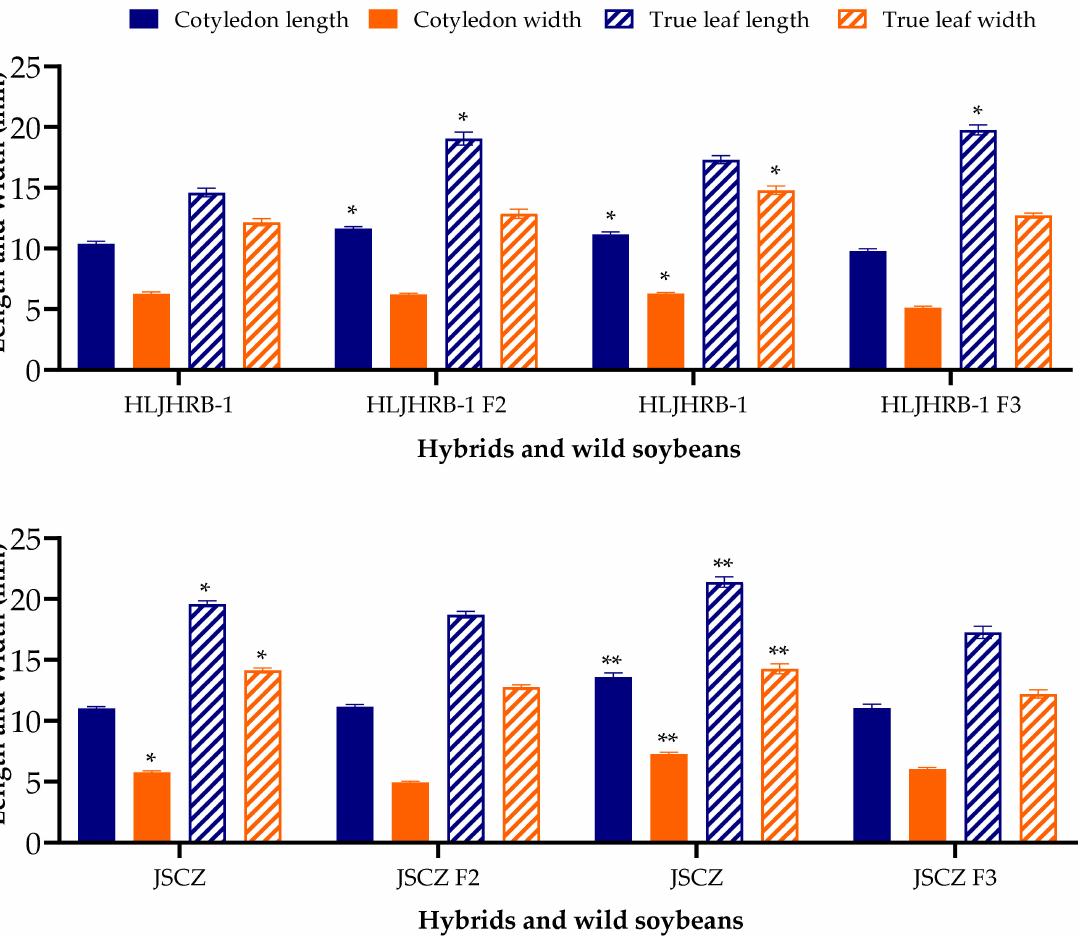
Figure 2. Size of cotyledon and true leaves of hybrids and wild soybeans. Note: * and ** indicate significant difference ( p < 0.05) and extremely significant difference ( p < 0.01) of the same trait between hybrids and their wild